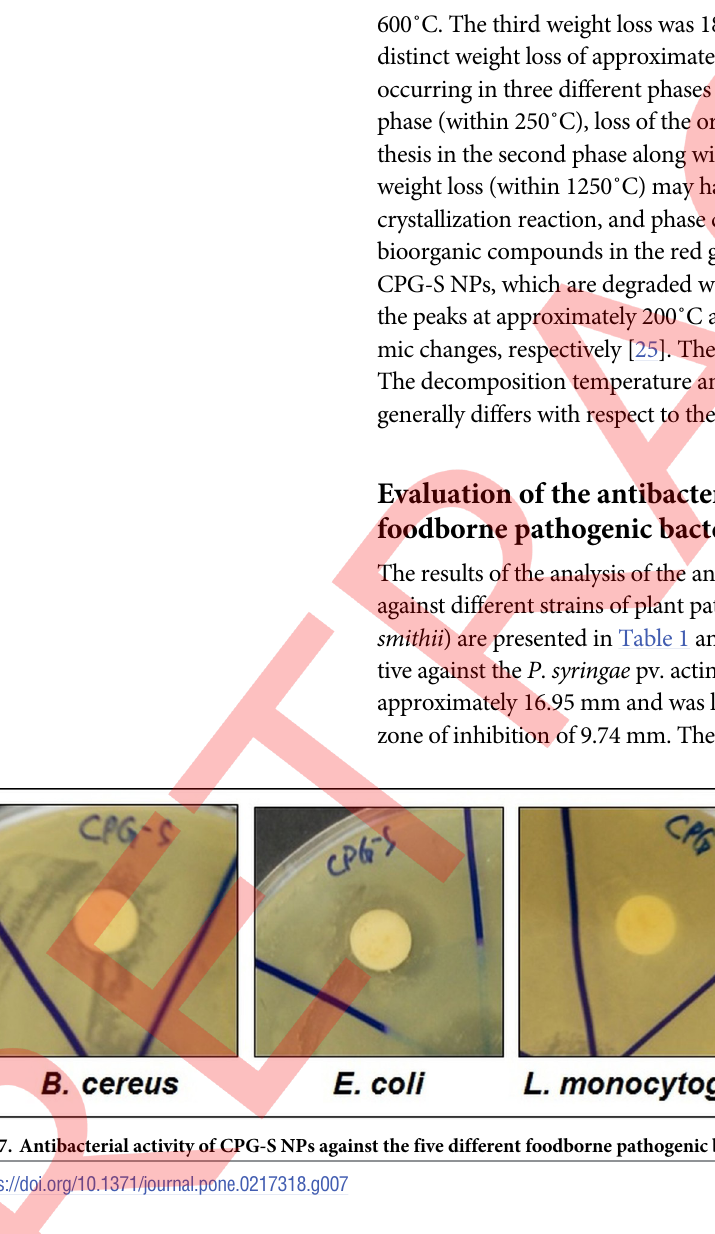
PLOS ONE | https://doi.org/10.1371/journal.pone.0217318 June 10,